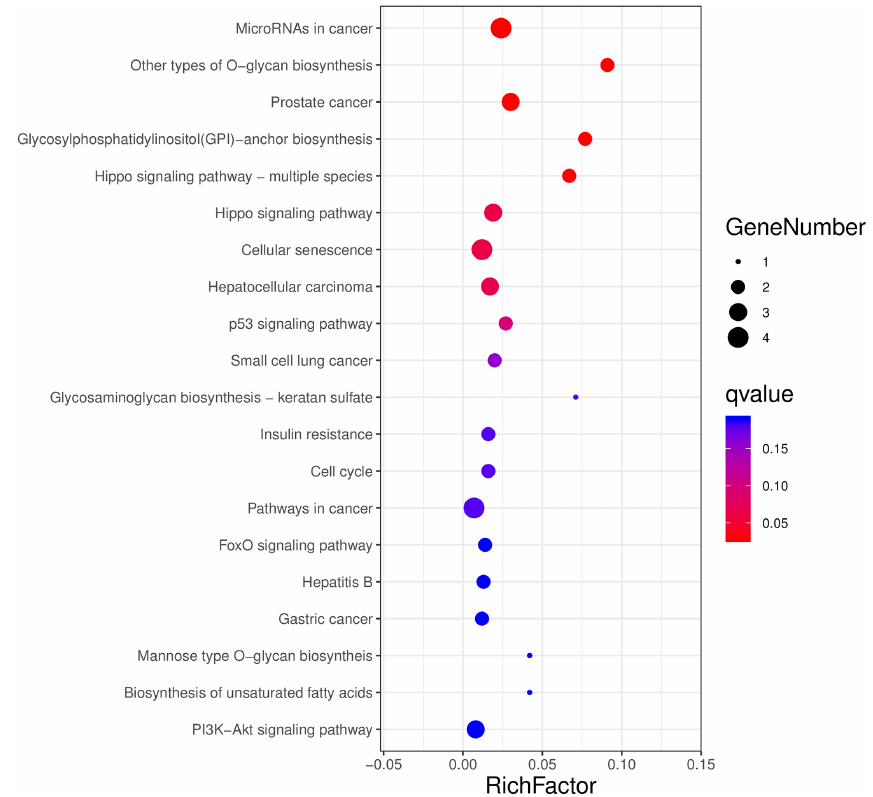
Figure 6. All the target genes were conducted using KEGG signaling pathway enrichment analysis. P value < 0.05 was considered statisti- cally significant.